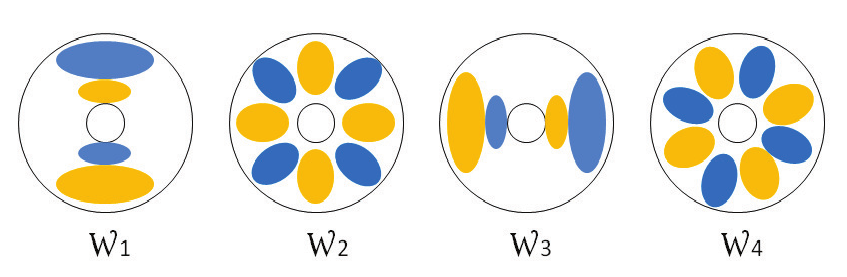
Figure 4. Schematic representation of four independent eigenfunctions in (3.3). They all have the same eigenvalue.